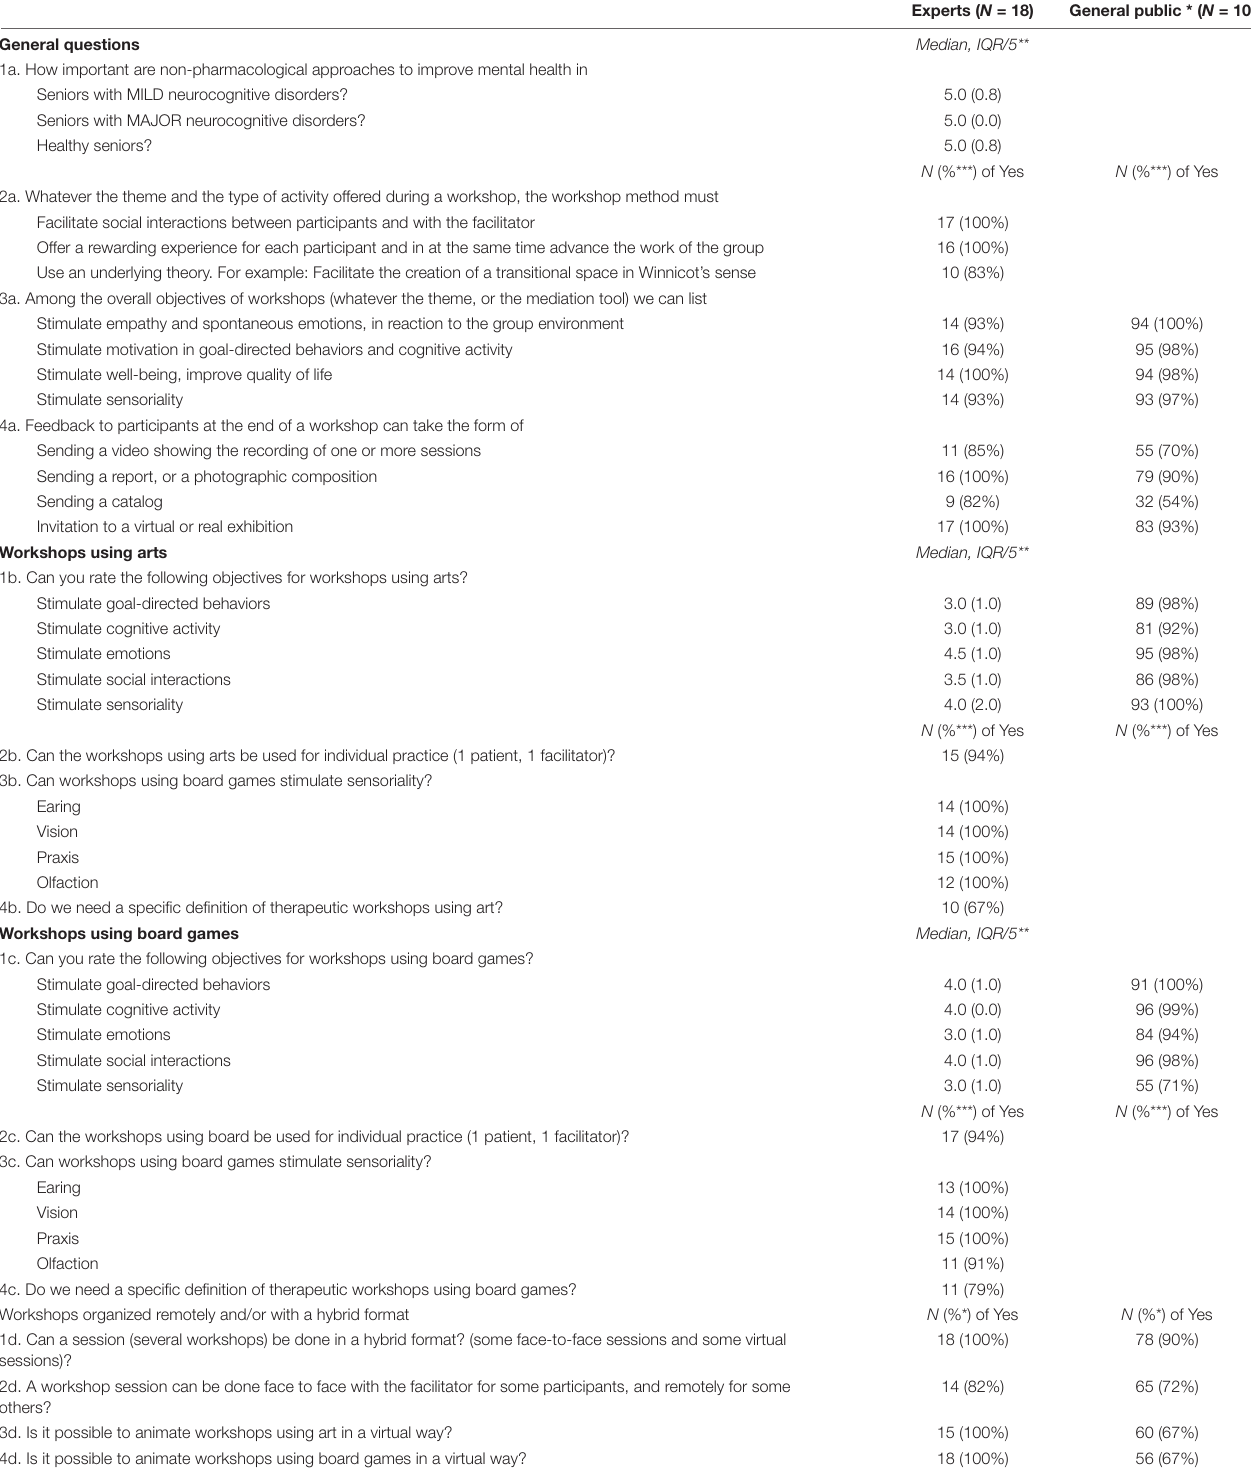
TABLE 1 | Delphi round 1 and 2 rating and yes-no questions (general questions/questions workshops using art and workshops using board